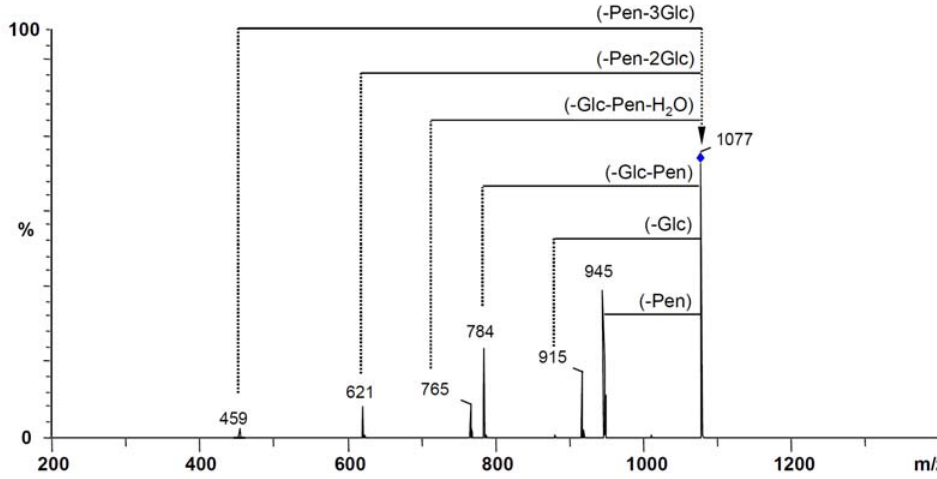
Figure 4. The CID spectra of parent ion [M − H] − with m/z 1077. The deprotonated ion is indicated by a vertical arrow. Pen = pentose [arabinose or xylose].